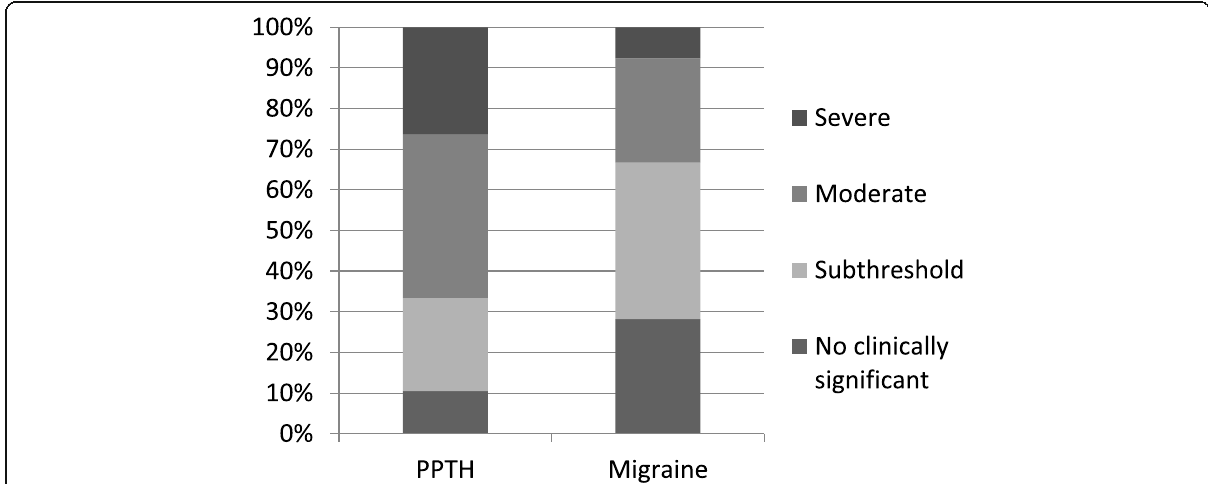
Fig. 2 Distribution of insomnia severity in subjects with persistent post-traumatic headache and migraine. PPTH: